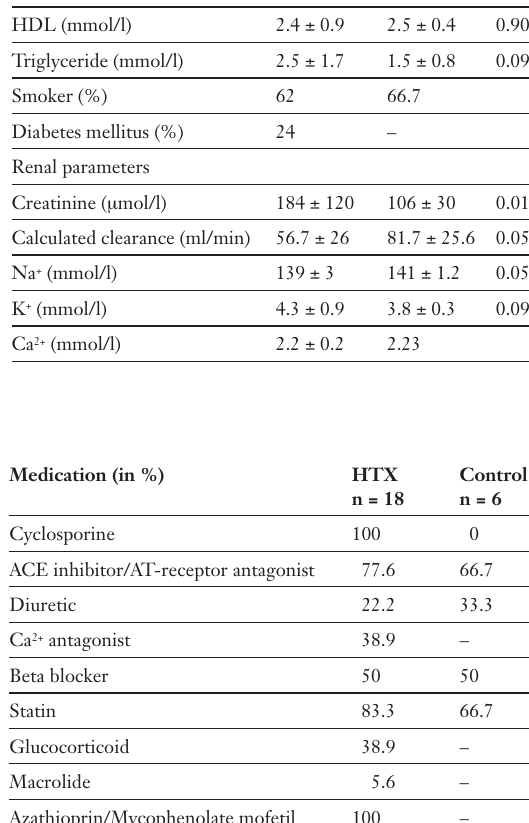
Clinical characteris- tics of the study population. HTx: Heart-trans- planted patients; sBP: systolic blood pressure, dBP: diastolic blood pressure, LDL: low density lipoprotein, HDL: high density lipoprotein, Na + : plasma sodium, K + : plasma potas- sium, Ca 2+ : plasma calcium. Data are expressed as mean ± SD. Creatinine clearance was calculated